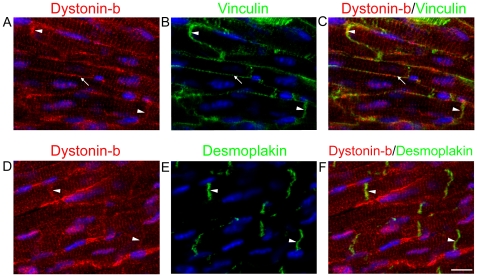
Dystonin-b localizes to the sarcolemma and at intercalated discs.Dystonin-b staining patterns of wild-type cardiac tissue were compared to those of vinculin (B, arrowheads) and desmoplakin (E, arrowheads) both known intercalated disc markers. In addition, vinculin is also found at the sarcolemma (B, arrow). The dystonin-b antibody localizes at the sarcolemma (A, arrow) and at the intercalated disc adhesion structure (A, arrowheads). Scale bar  = 10 µm for all images.